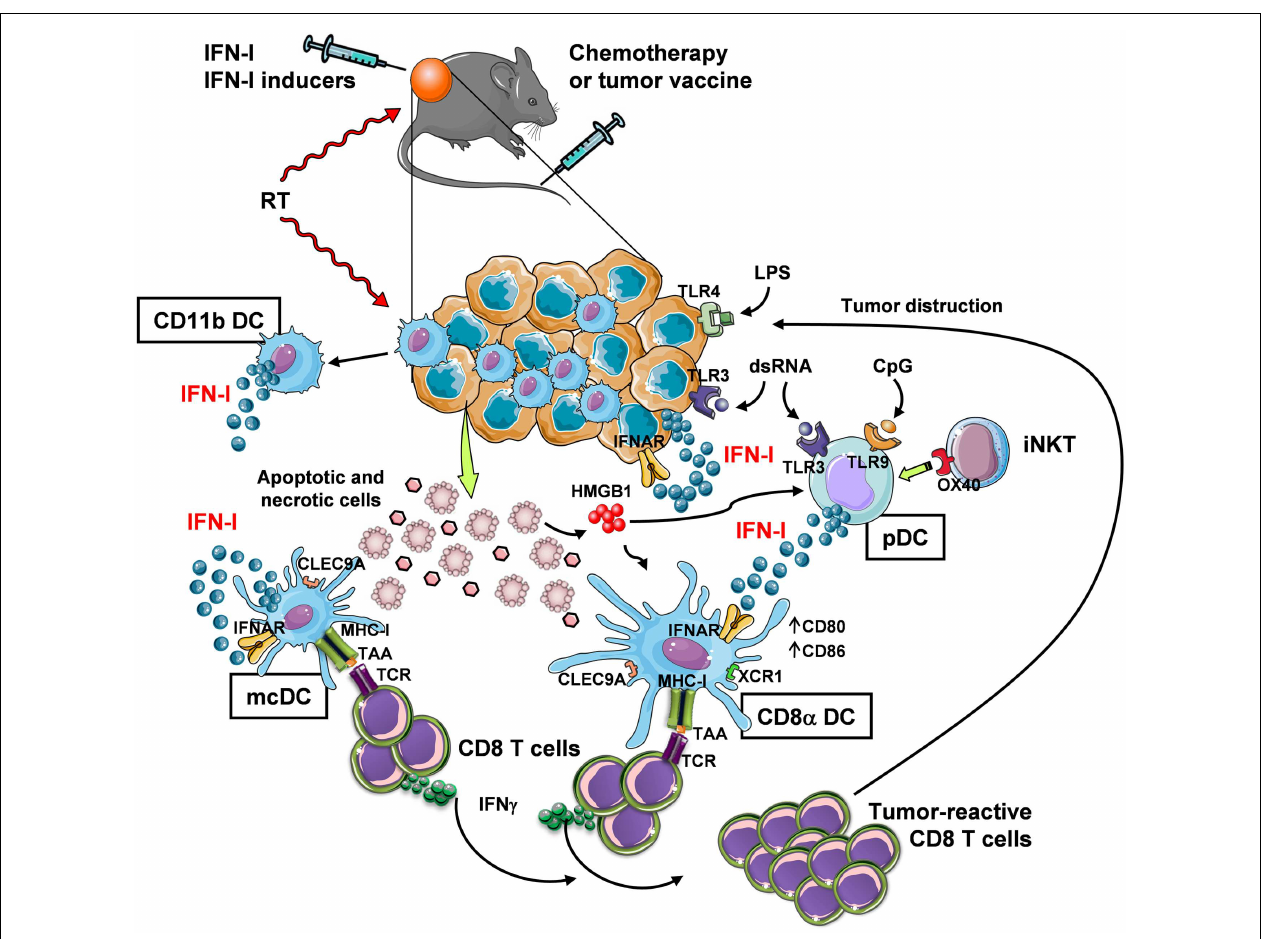
the tumor site IFN-I may be made available in different manners: (1) via intratumoral injection, (2) by RT, which stimulates IFN-I release by infiltrating myeloid CD11b DC (and possibly other immune and non-immune cells), and (3) by intratumoral delivery of IFN-I-inducing substances, such asTLR ligands. SomeTLR ligands can also bind to tumor cells that expressTLR3 andTLR4 to trigger autocrine IFN-I production and stimulation of DC. Alternatively,TLR ligands, such as dsRNA and CpG, stimulate pDC to produce large amounts of IFN-I. IFN-I secretion by pDC may also be stimulated by invariant NKT (iNKT) cells via OX40 and HMGB1 released by dying tumor cells.The final outcome of these events is the expansion of tumor-reactive CD8T cells with killing